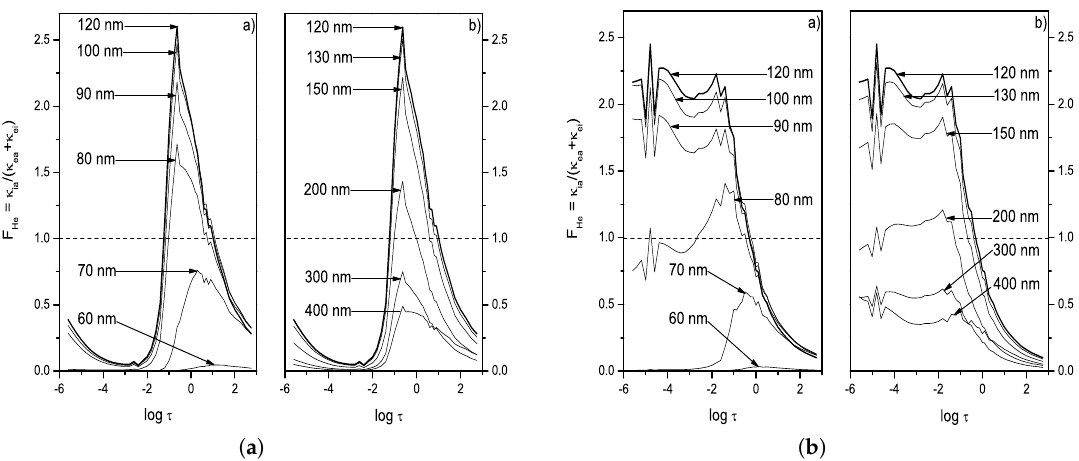
Figure 18. ( a ) behaviour of the quantity F He = κ ia / ( κ ea + κ ei ) (ratio of the absorption coefficients of processes (2), (5) and (6)) within the atmosphere of a DB white dwarf in the case log g = 8 and T ef f = 12,000 K; ( b ) as in ( a ), but for the case log g = 8 and T ef f = 14,000